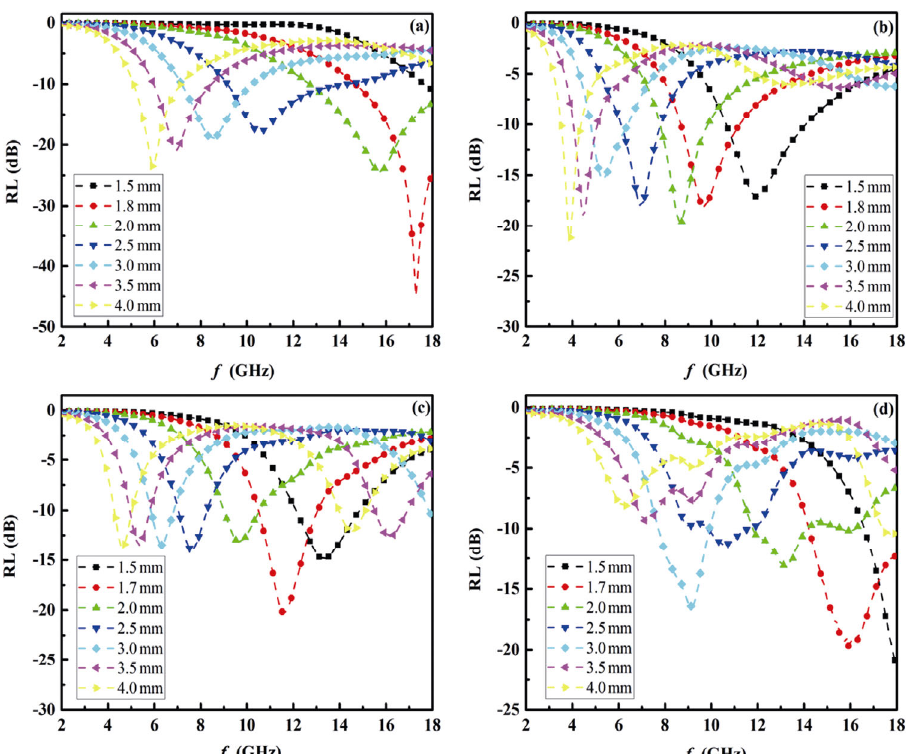
Fig. 5 RL curves of PVA mixed BFTO- x ceramics in the frequency range of 2–18 GHz: (a) x = 0.2, (b) x = 0.4, (c) x = 0.6, and (d) x = 0.8.